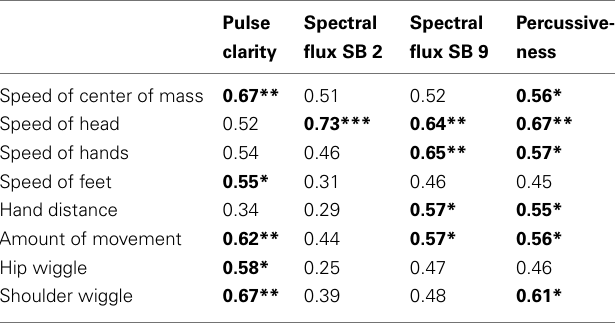
Table 2 | Results of the correlation between movement and musical